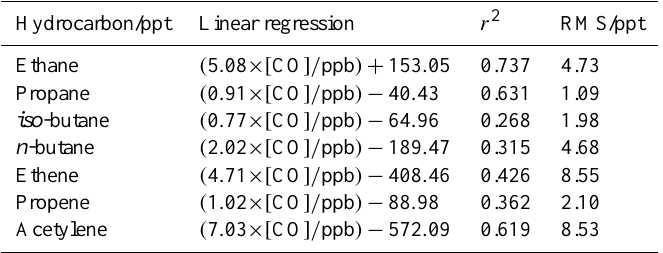
Table 1. Parameters used to fit hydrocarbon data as a function of the CO concentration. Hydrocarbon concentrations were used in ppt, while CO concentrations were in ppb. RMS refers to the root mean square difference between the observed and calculated values.